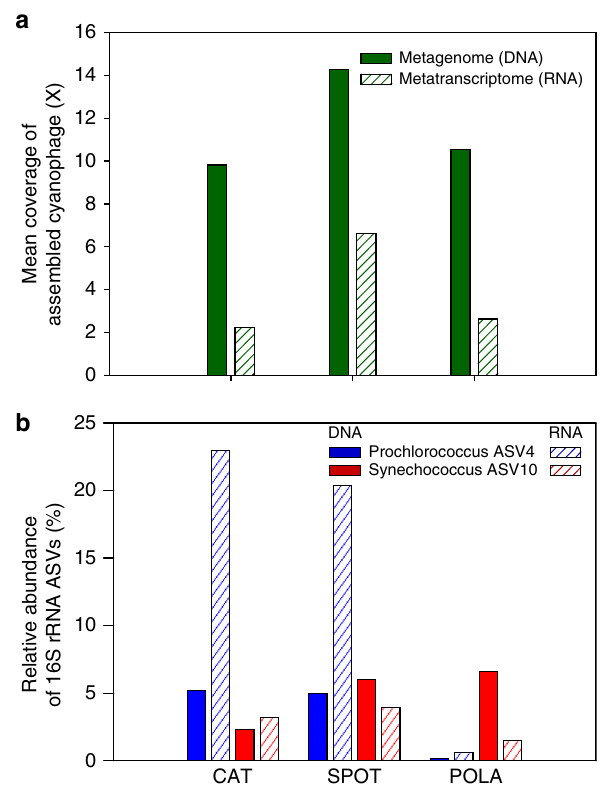
Fig. 3 Matching assembled cyanophage with Synechococcus host using expression patterns. Presence and activity of the assembled cyanophage and its potential hosts in October 2012: a Mean coverage (after removing the top 25% most abundant contig positions) of the assembled cyanophage, b Amplicon single variants (ASVs) relative gene and transcript abundance of 16S-rRNA of the two most abundant cyanobacterial ASVs: Prochlorococcus ASV4 and Synechococcus ASV10. Note the near-absence of Prochlorococcus in POLA, in contrast to Synechococcus and the phage RNA, leading us to infer that the phage infected Synechococcus . Each group of bar plots, denoted by site name, represents data from a single